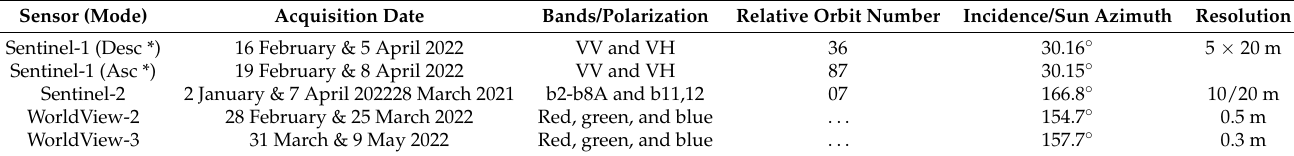
Table 1. Description of satellite images used in this